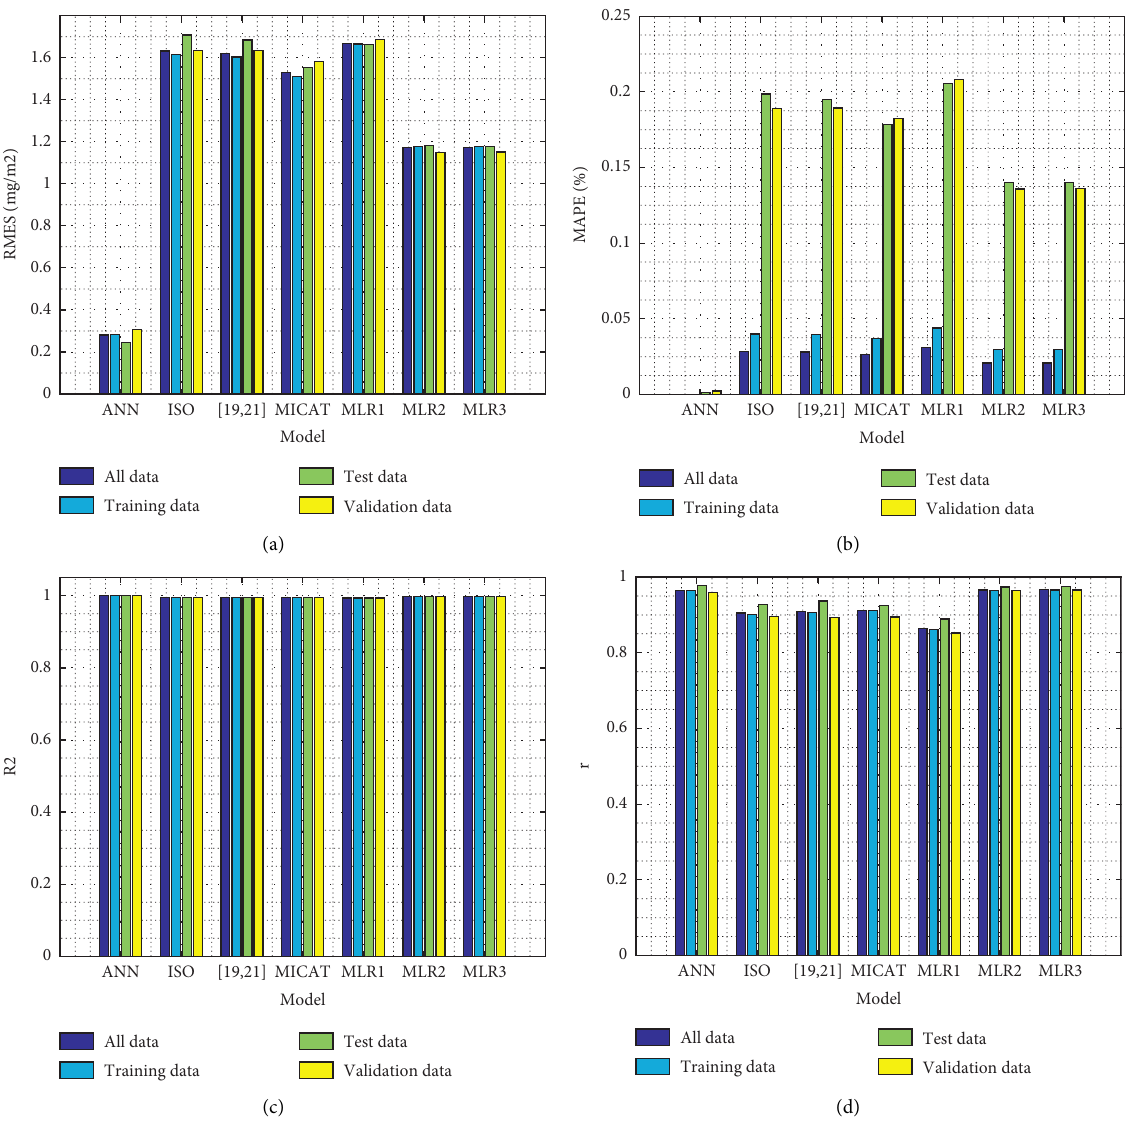
Figure 11: Calculated statistical parameters of predicted